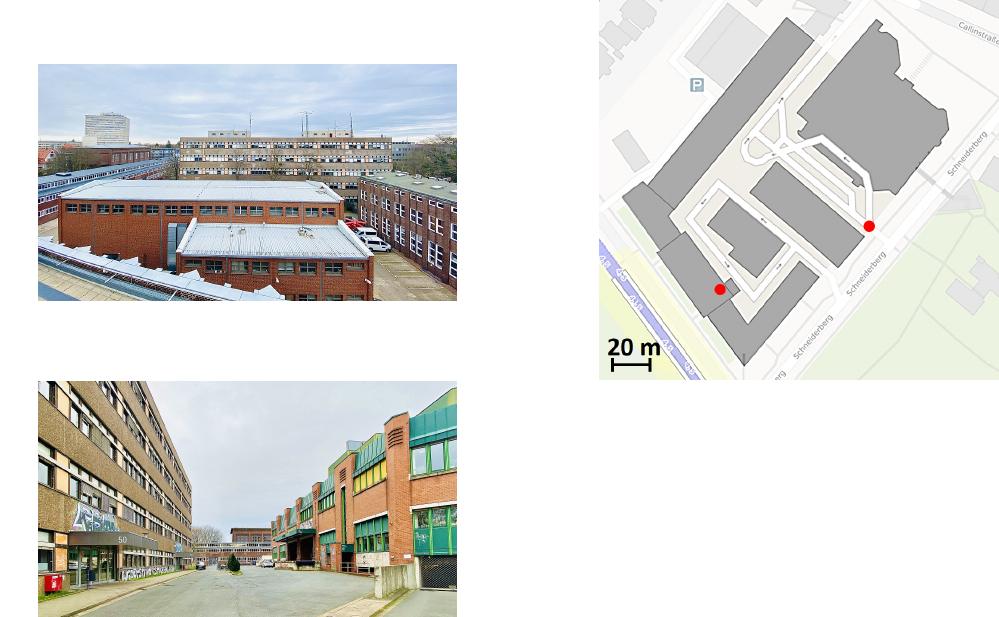
Figure 8. An overview of the measured area. The map-based representation is the middle figure, and on its left and right side are the images corresponding to the left and right red circles, respectively [32].